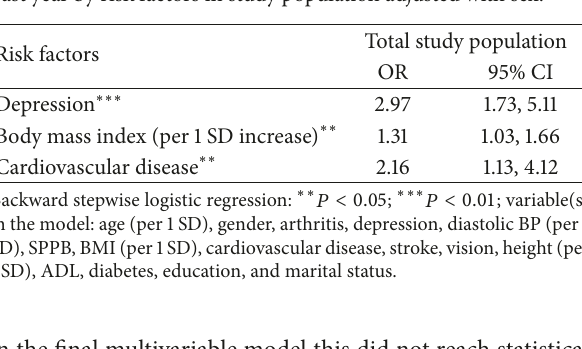
Table 4: Logistic regression predicting odds of having fallen in the past year by risk factors in study population adjusted with